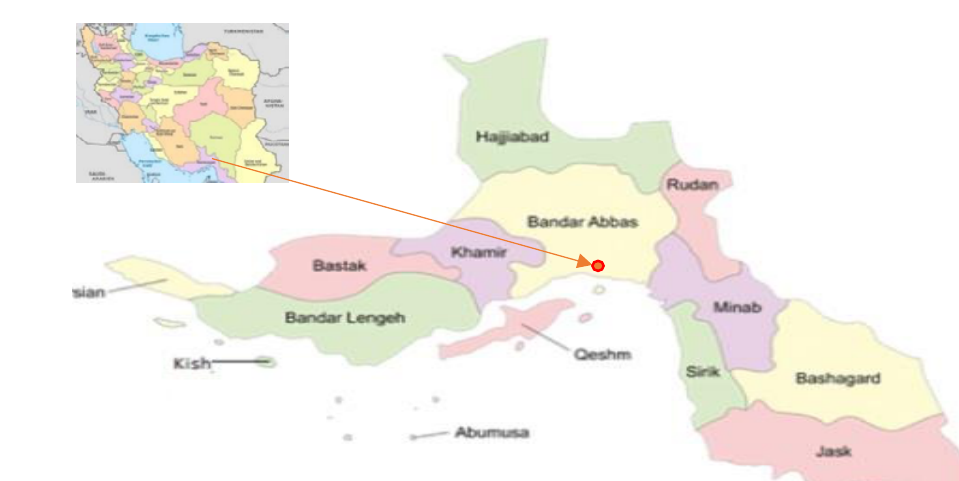
Figure 1. The locality of Gameron petro industry Fig. 1. The locality of Gameron Petro Industry Complex